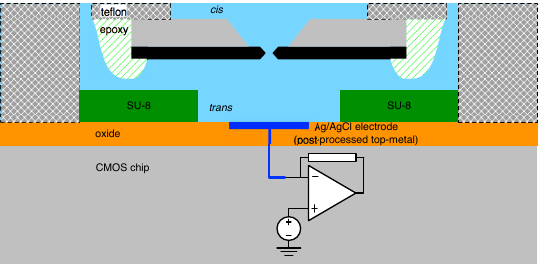
Figure 19. CMOS to solid-state nanopore interface as described in [82]. The nanopore chip is affixed to a non-reactive cell material on top.